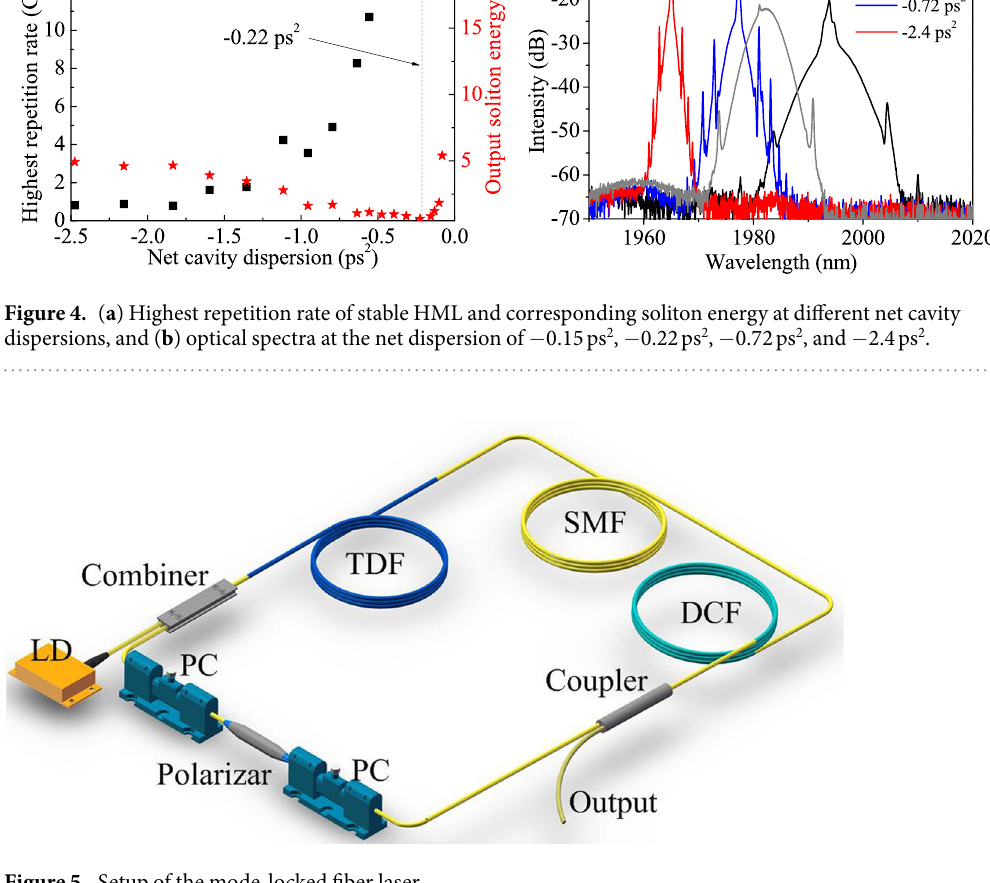
Figure 5. Setup of the mode-locked fiber